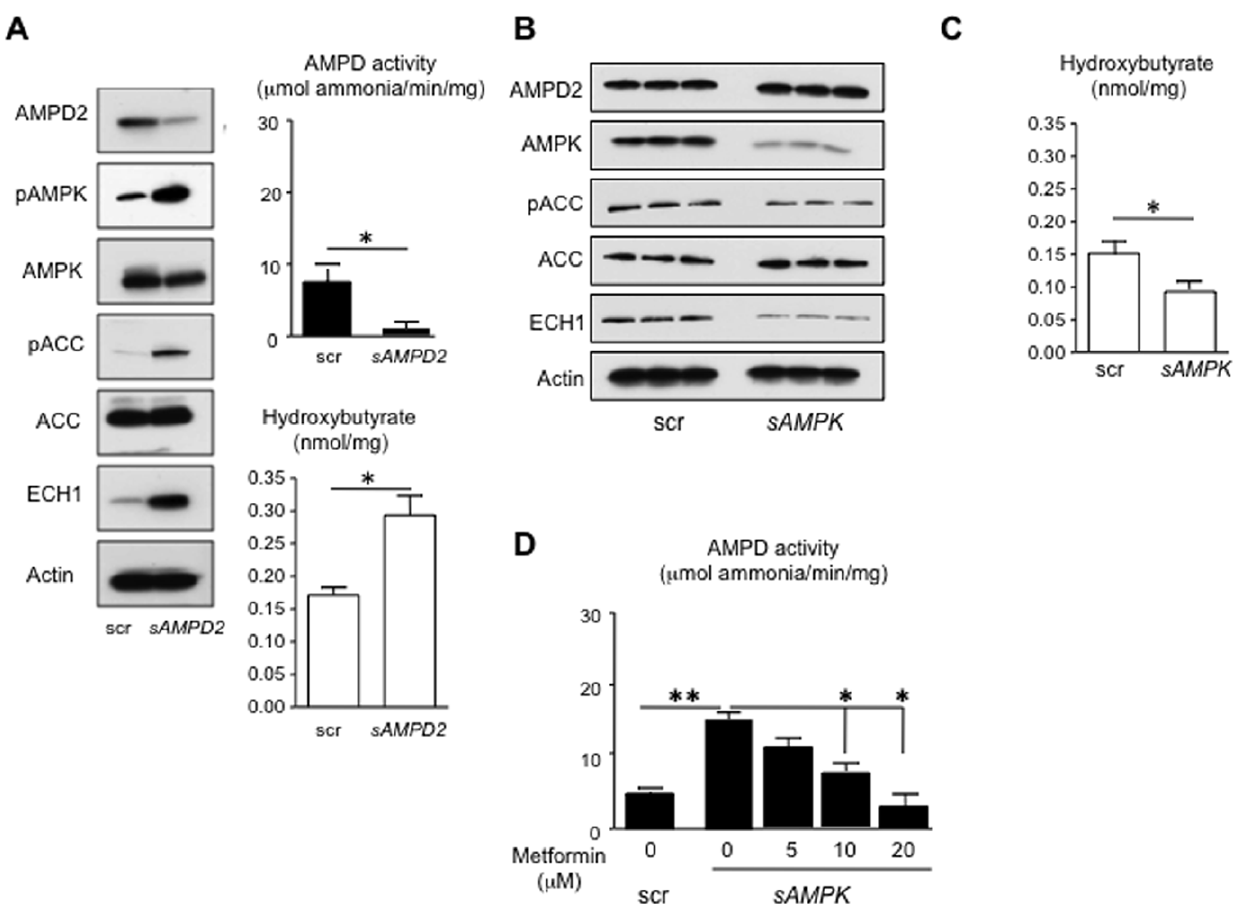
Figure 4. AMPK activation in AMPD2-deficient cells. A) Silencing AMPD2 expression in human hepatocytes spontaneously up-regulates the activation of AMPK. Transduction of HepG2 cells with lentiviral particles codifying for a specific silencer for AMPD2 results in significantly lower levels of AMPD activity. This is paralleled with increaseded levels Thr172 pAMPK expression as well as of their target genes ECH1 and Ser79 pACC. Up- regulation of ECH1 is accompanied with higher intracellular b -hydroxybutyrate levels. *p , 0.05 B) Blockade of AMPK expression activates AMPD2. Stable silencing of AMPK is associated with significant down-regulation of ECH1 and phosphorylation of ACC at Ser79. In contrast, no change in AMPD2 expression is observed. C) Silencing AMPK expression in human hepatocytes spontaneously decreases the levels of intracellular b - hydroxybutyrate D) Metformin blocks AMPD activation in AMPK-deficient cells in a dose-dependent manner. *p , 0.05, **p , 0.01.